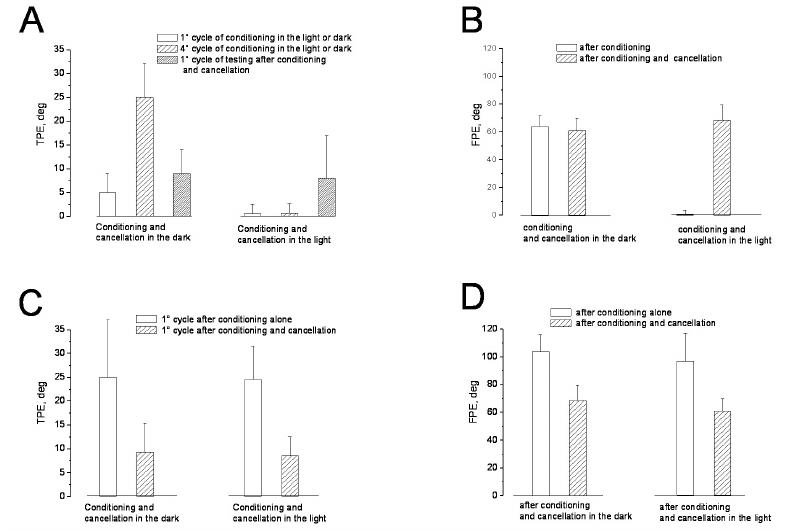
Figure 6. TPE and FPE induced by conditioning and conditioning plus cancellation procedures in dark and light conditions (session 3 and 4). Column values represent the mean and SD of perceptual error. ( A ) TPE of 1° and 4° conditioning cycles (two left columns) and 1° testing cycle after conditioning and cancellation (right column). ( B ) FPE at the end of the conditioning procedure (right column) and the end of testing after conditioning plus cancellation (left column). ( C ) Comparison between TPE of one testing cycle after conditioning (left column) and after conditioning plus cancellation in the dark and light (right column). ( D ) Comparison of testing FPE after conditioning alone (left column) and after conditioning plus cancellation (right